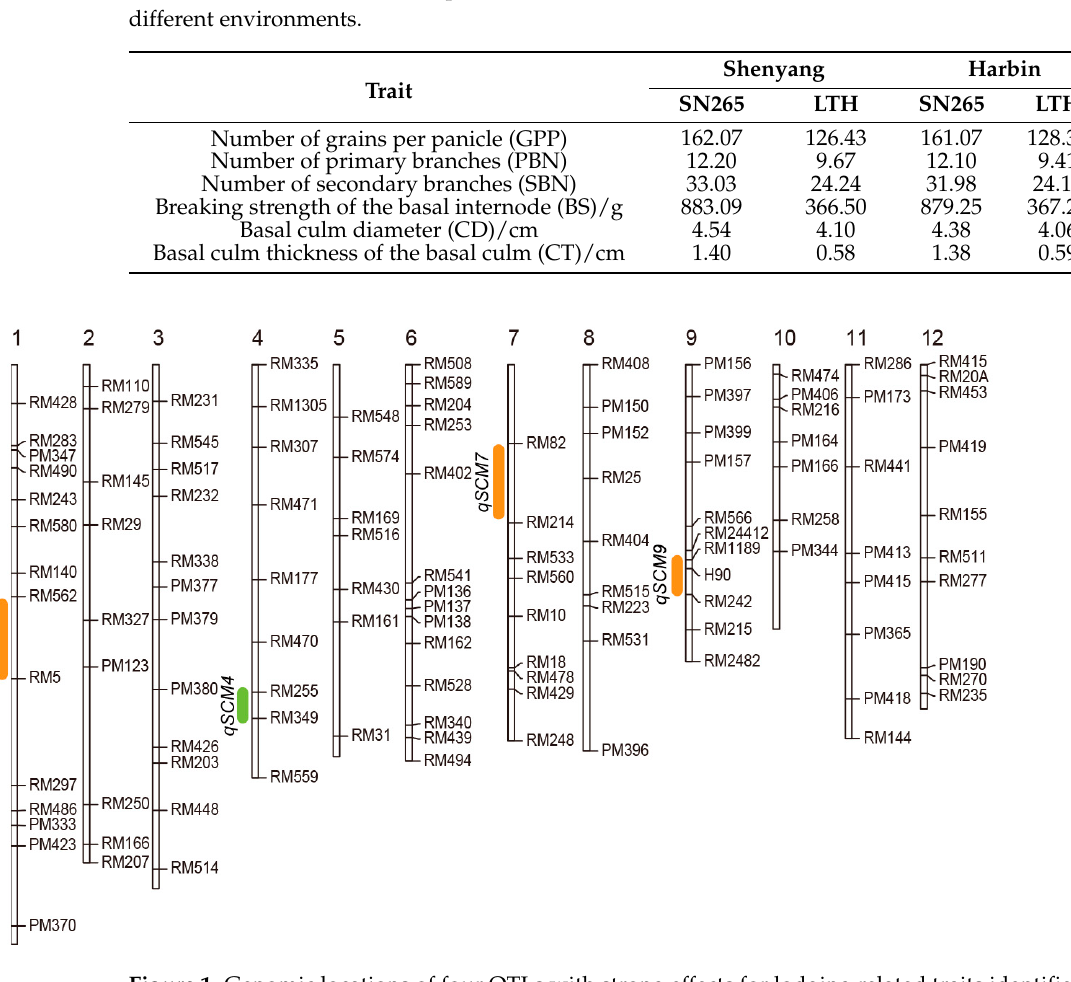
Figure 1. Genomic locations of four QTLs with strong effects for lodging related traits identified in the RILs population. Green indicates positive effect inherited from LTH. Orange indicates positive effect inherited from SN265. 1–12 indicates chromosome 1 to chromosome